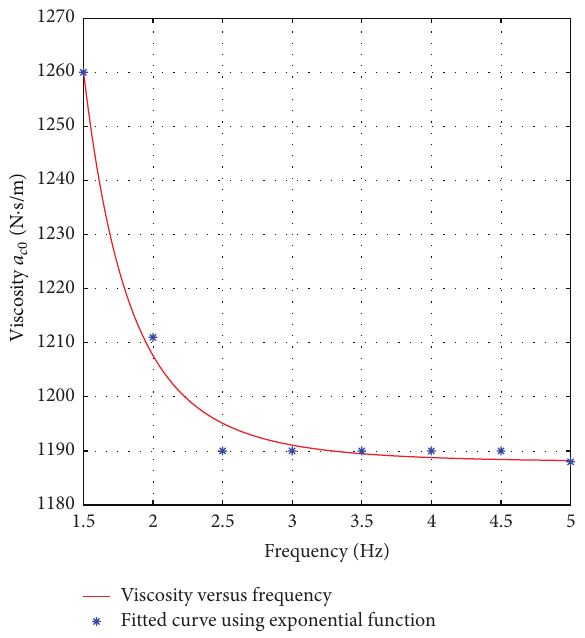
Figure 7: Variation MR damper viscosity 𝑎 𝑐0 versus